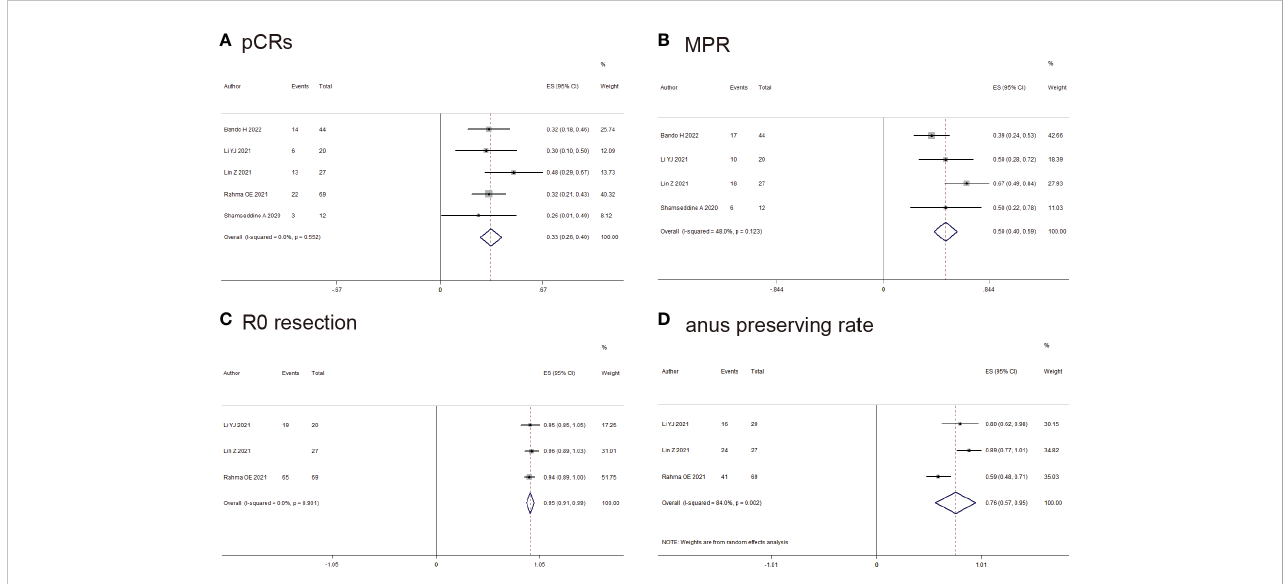
FIGURE 4 Outcomes of neoadjuvant immunotherapy for rectal cancer. (A) pathological complete response (pCRs); (B) major pathological response (MPR); (C) RO- resection; (D) Anus preserving